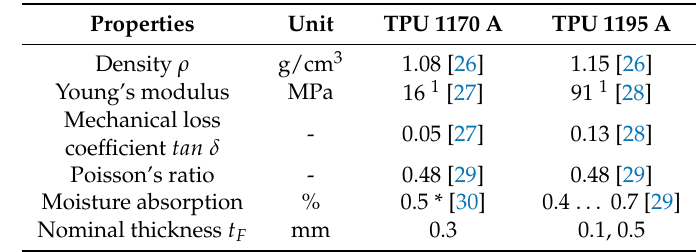
Table 1. Properties of polymer films under standard atmospheric conditions (i.e., 23 ◦ C, 50% relative